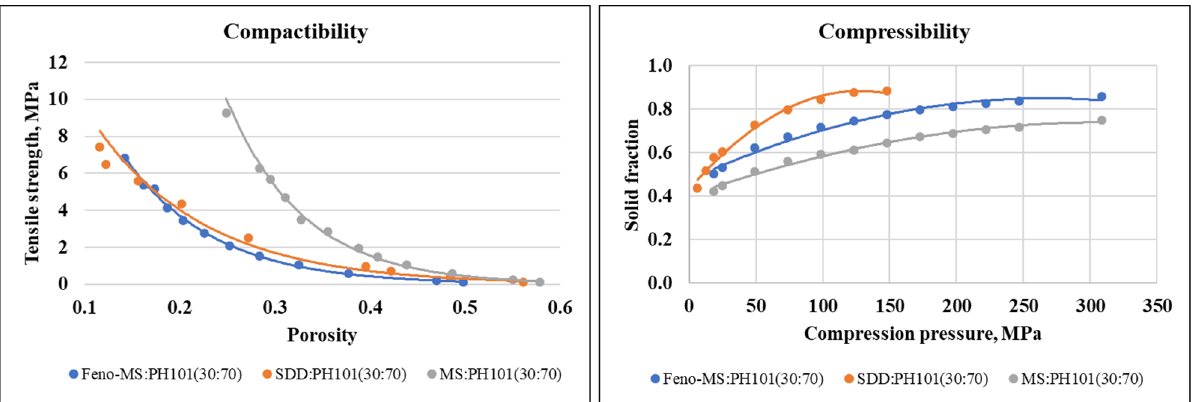
Figure 7. The compactibility and compressibility profiles of blending a mixture of MCC PH101 and three different powder samples at a weight ratio of 30:70 ( w / w ): 30%-Feno-MS (blue), 30%-Feno-SDD-PVP (orange), and pure MS (grey).